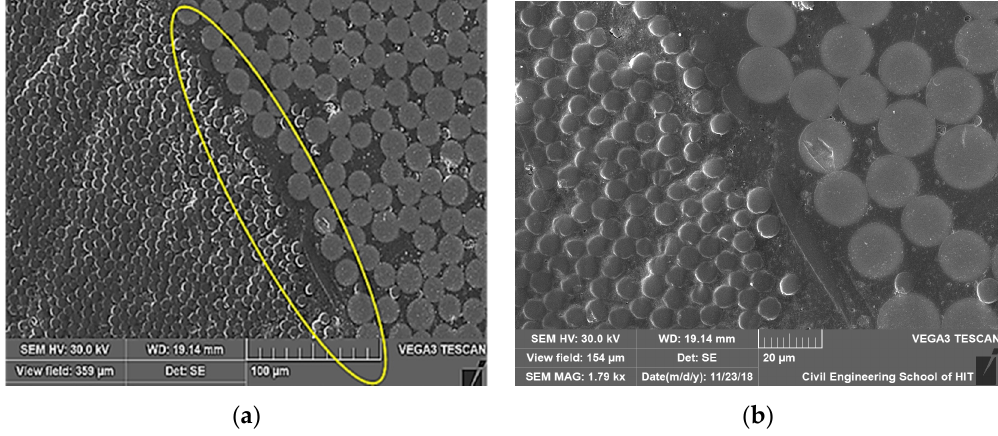
Figure 14. Untreated samples with random presence of unusual gap with a matrix rich area in carbon fiber core / glass fiber shell, interface zone, ( a ) SEM picture of lower amplification; ( b ) amplified SEM picture of the circled zone.